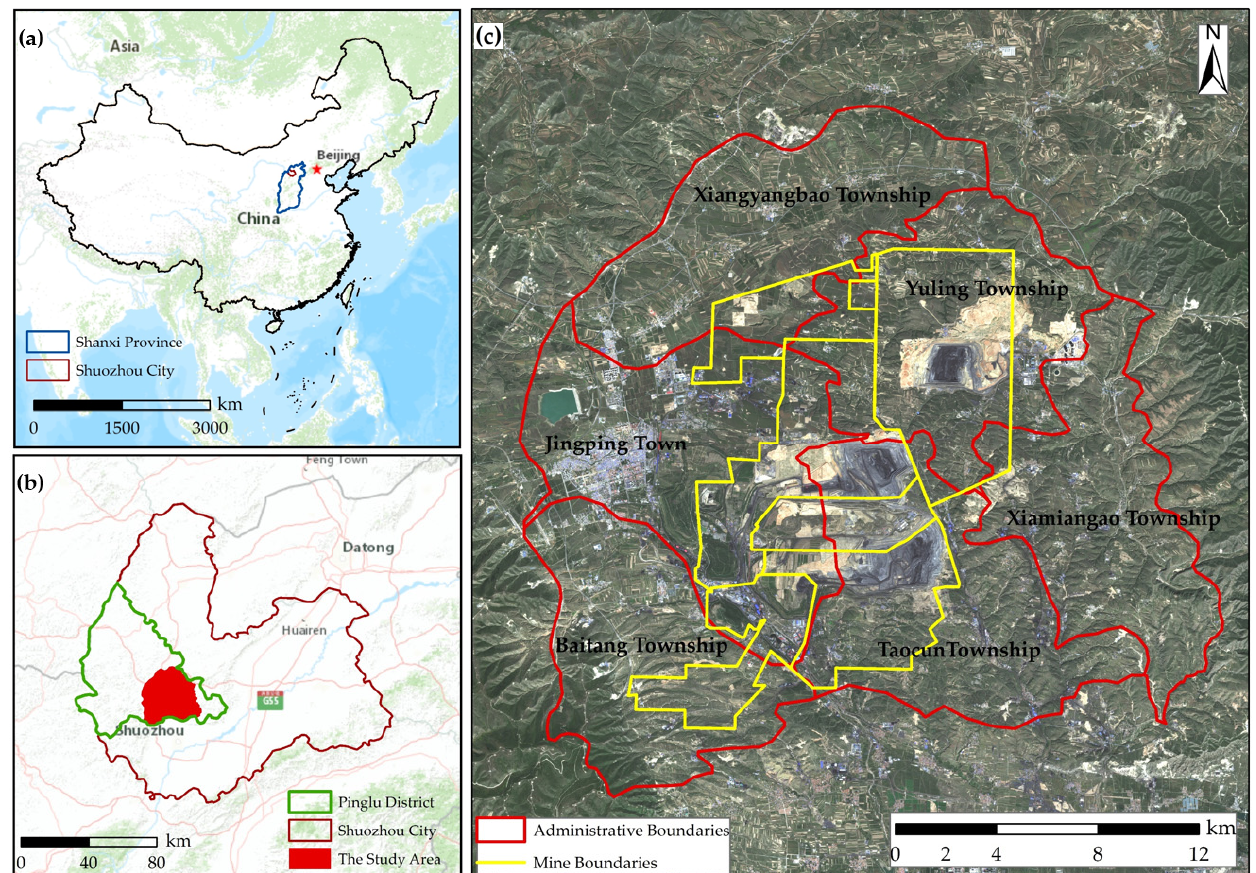
Figure 1. Location of the mine–agriculture–urban compound area. (The base maps of ( a , b ) are the color version of the map of China that comes with ArcGIS, the base map of ( c ) is the 2020 Landsat remote sensing image data that was from United States Geological Survey (https://earthexplorer.usgs.gov/ accessed on 3 March 2022).)